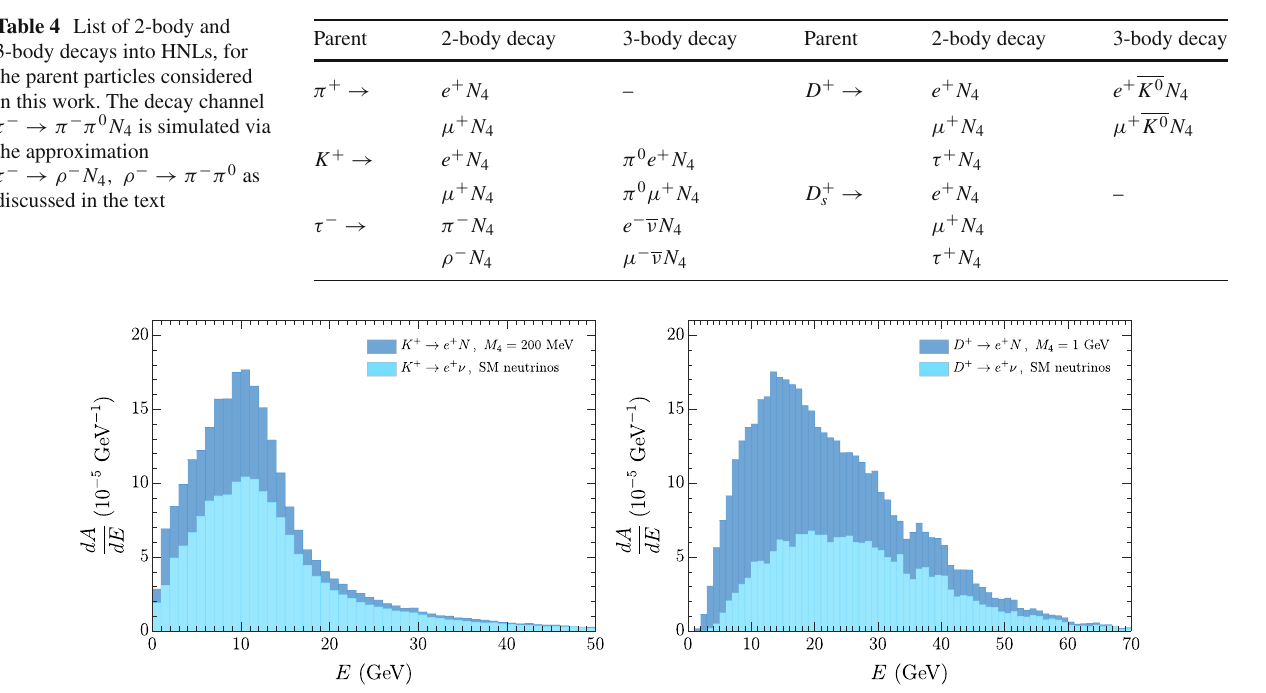
Fig. 3 Detector acceptance (dark blue in both panels) as a function of the neutrino energy, for neutrinos with a mass of 200 MeV, produced from K + → e + N 4 decays (left panel), and neutrinos with a mass of